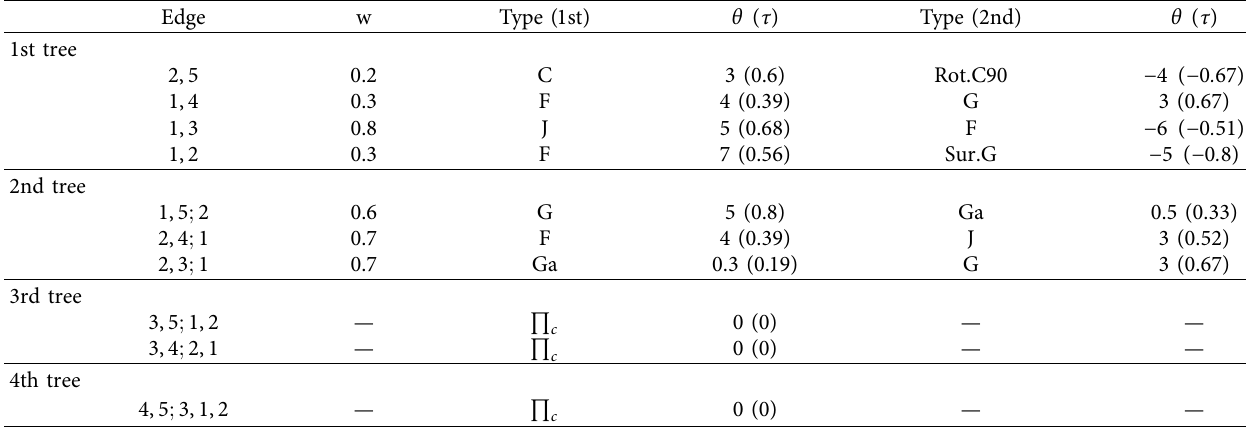
Table 3: Summary of 2-levels truncated R -vine copula mixture